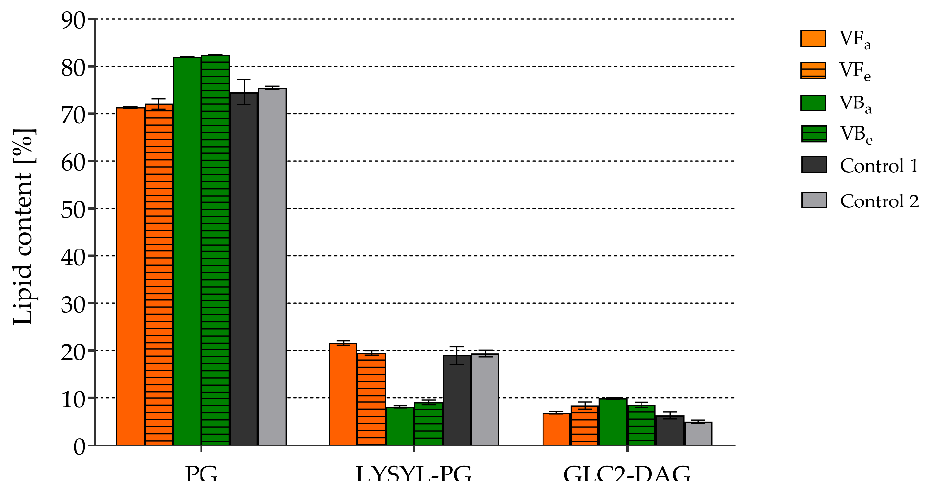
Figure 4. The effects of V. opulus extracts on the contents of the main classes of lipids in the cell membrane of S. aureus ATCC 43300; PG—phosphatidylglycerols; LYSYL-PG—lysyl-phosphatidylglycerols; GLC2-DAG—diglucosyldiacylglycerols; VF— V. opulus fruit extract; VB— V. opulus bark extract; a/e—acetonic/ethanolic extract; Control 1—bacteria in medium alone; Control 2—bacteria in medium containing 2.5% ethanol.